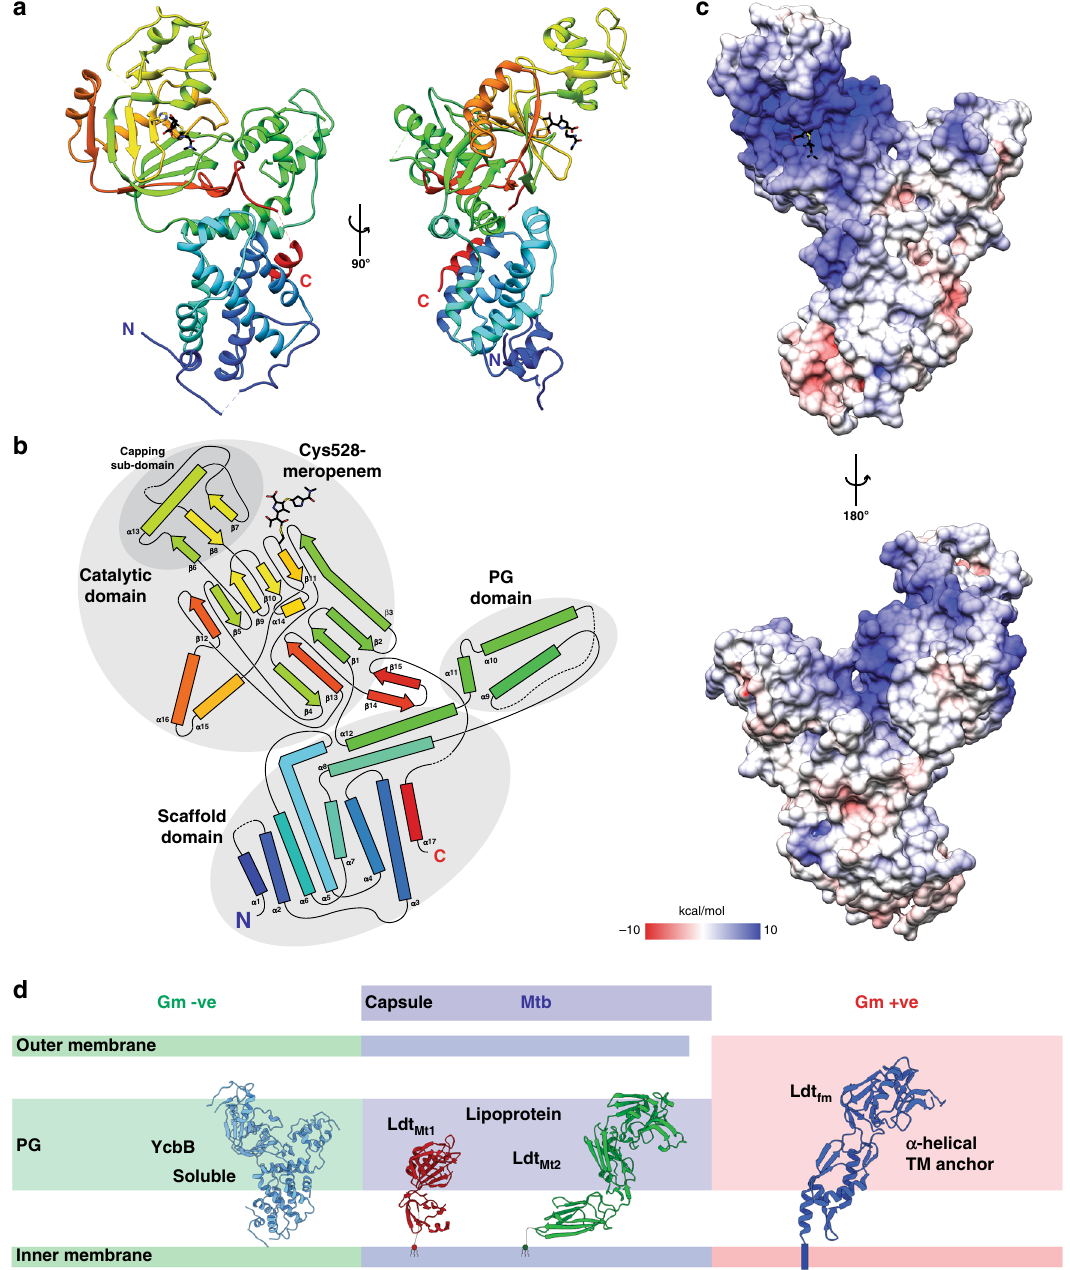
Fig. 1 Overall architecture of E. coli YcbB. a The crystal structure of YcbB-meropenem acyl-enzyme complex in ribbon representation, coloured in rainbow from N-terminus (blue) to C-terminus (red). Meropenem stick representation is coloured in black and by heteroatom. Two views related by a 90° rotation along the y -axis. b Topology diagram of YcbB-meropenem acyl-enzyme complex, coloured as in a . The catalytic, PG and scaffolding domains are annotated and circled in grey. c Electrostatic surface representation of YcbB in two views related by a 180° rotation around the y -axis. d Diversity of structurally characterised L,D-transpeptidases. Gram negative (green background), soluble YcbB in sky blue; Mycobacterial (blue background), lipoprotein Ldt Mt1 (PDBID 5E5L 8 ) and Ldt Mt2 (PDBID 5DU7 8 ) in red and green; Gram positive (red background), TM anchored Ldt fm (1ZAT 16 ) in dark